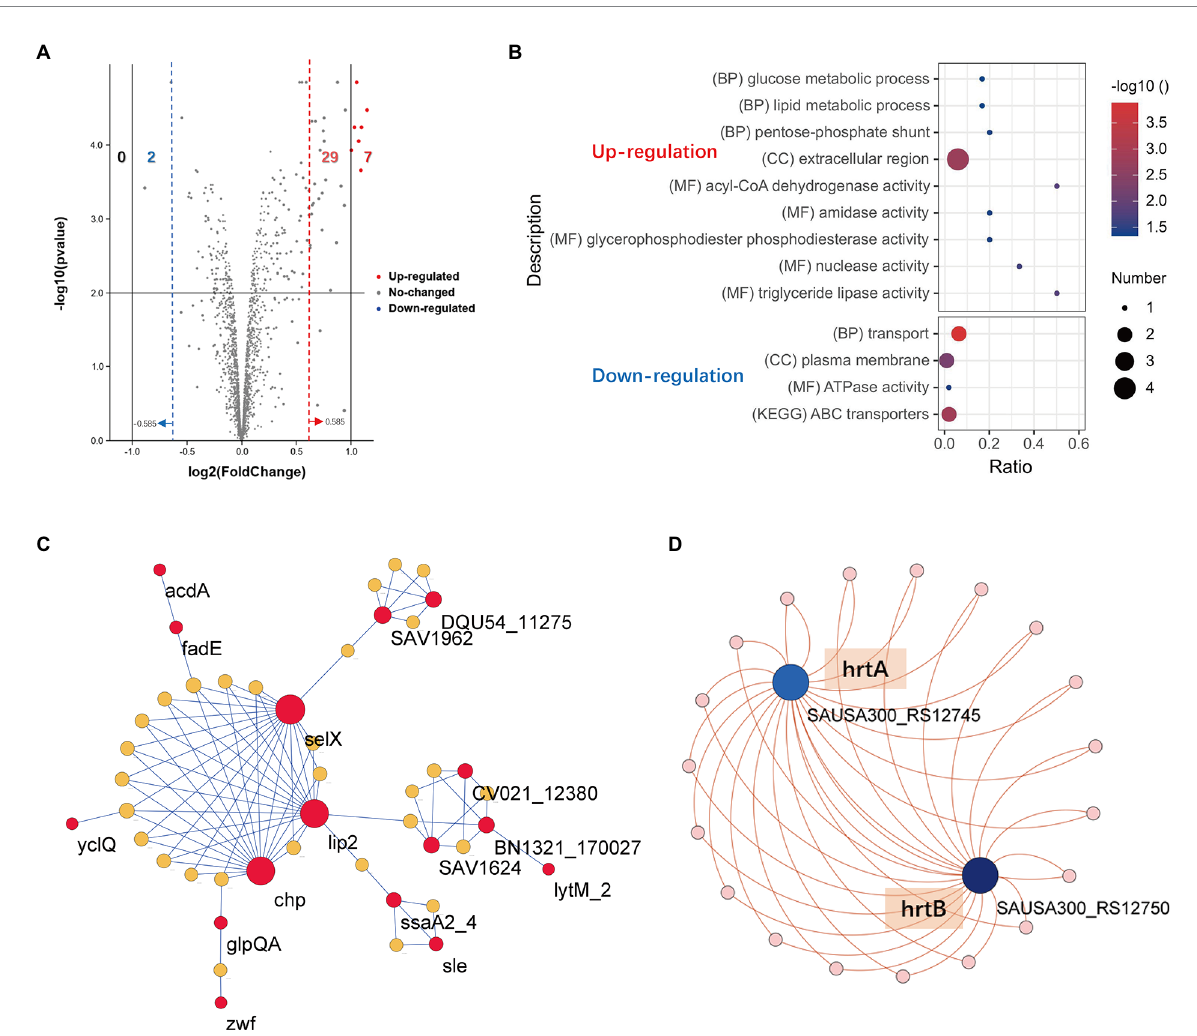
FIGURE 2 Proteomics profile change of S. aureus treated with TF. (A) Volcano plot visualizing the DEPs. The vertical lines divide the fold-change values. The right (red) vertical line corresponds to a change in log 2 FC > 0.585, while the left (blue) vertical line corresponds to a change in log 2 FC < − 0.585. The horizontal line is corresponds to a − log10 p value of 0.05. (B) Functional enrichment analysis of the upregulated and downregulated DEPs. (C) The PPI network of the 16 upregulated DEPs and 28 associated candidate genes created by the StaphNet web server. (D) The PPI network of the 2 downregulated DEPs and 19 related candidate genes created by the StaphNet web server. The interactions between proteins and the candidate gene symbols are shown in Supplementary Table